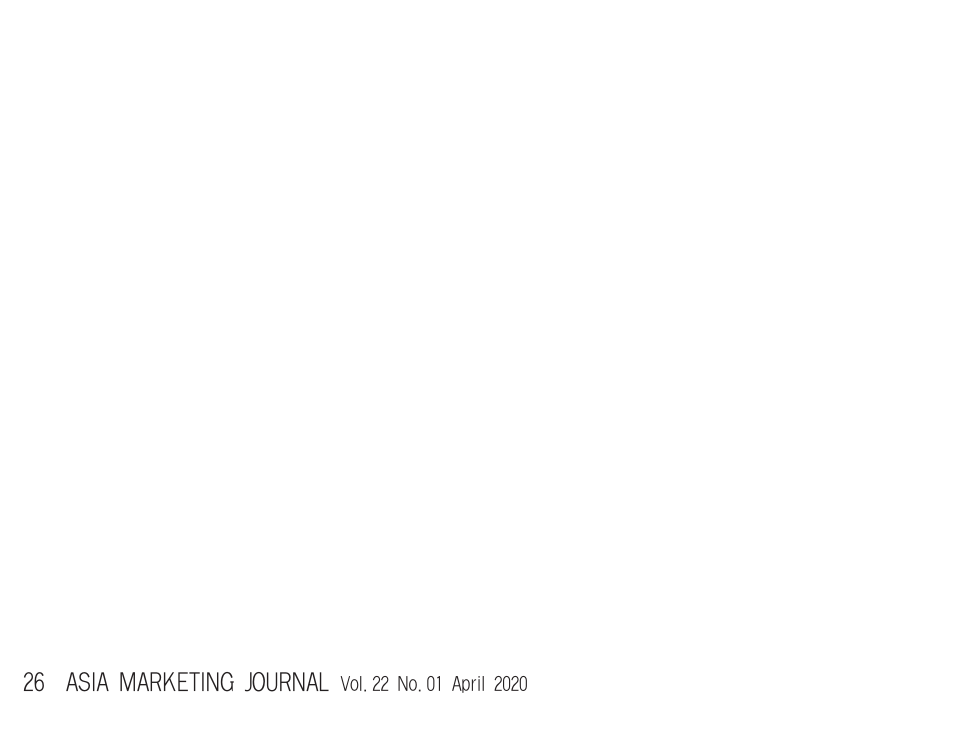
= the mean of the nth predictor variable for the treatment group before matching, = the mean of the nth predictor variable for the nontreatment group before matching, and = the number of predictor